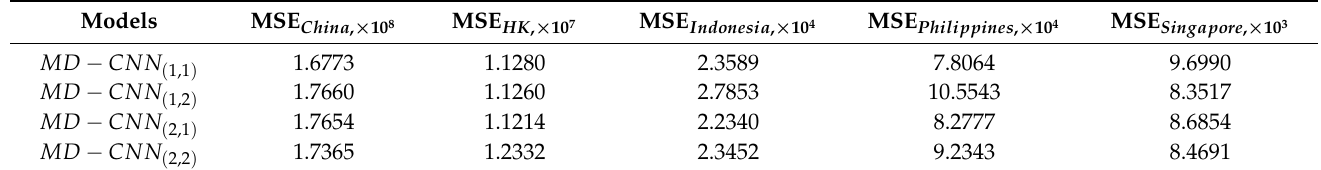
Table 2. Performance of MD-CNN model with different parameters using the model tuning dataset.